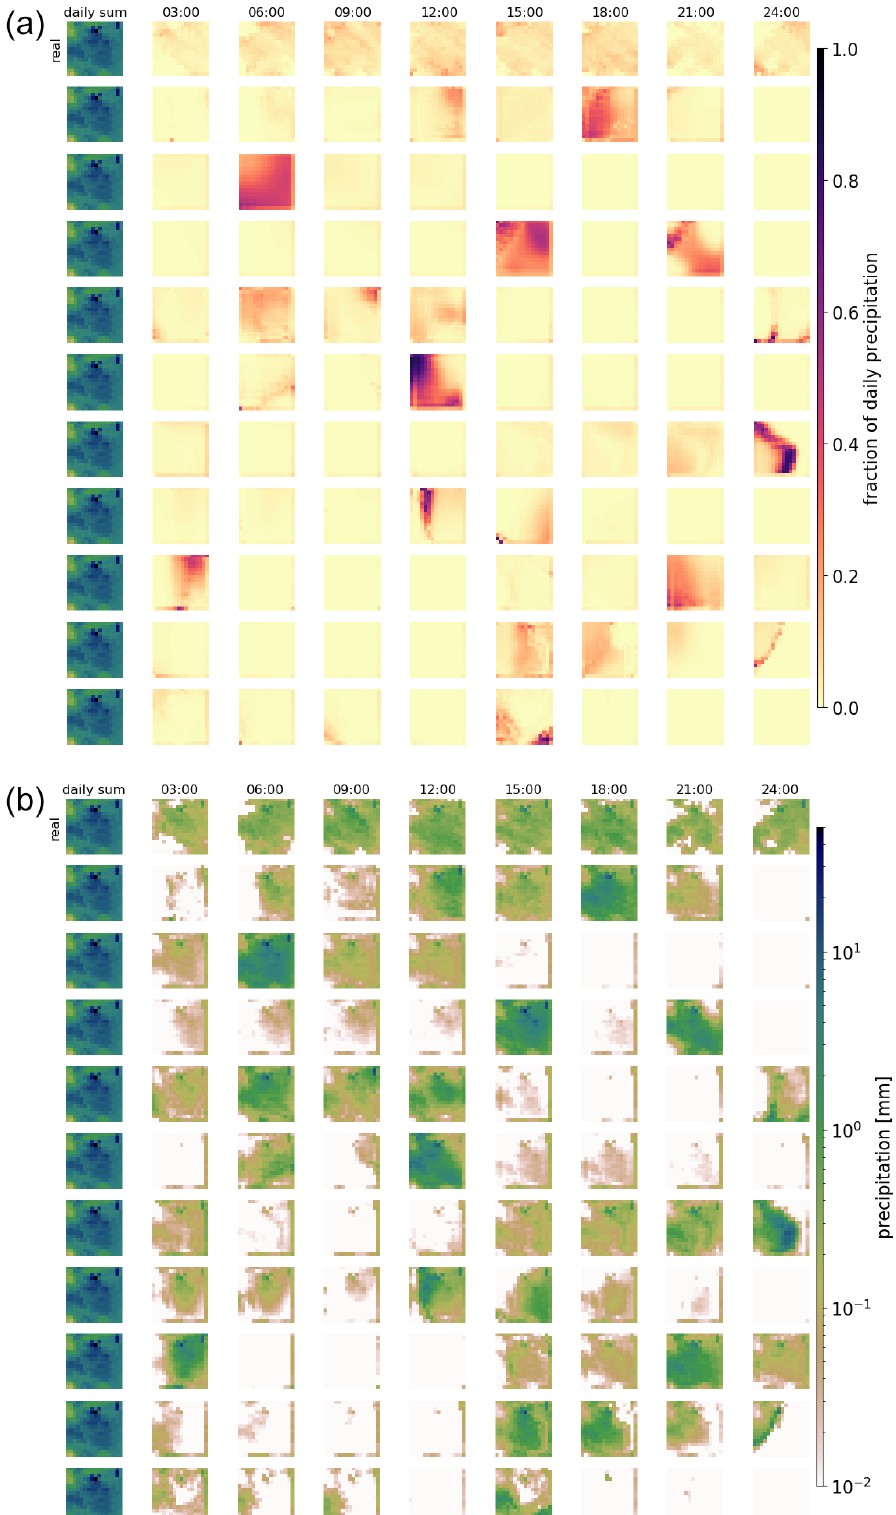
Figure 3. Real and generated examples of the fraction of hourly precipitation patterns for one daily precipitation sum and the hourly precip- itation itself. Panel (a) shows the generated fractions, and (b) shows the corresponding hourly precipitation patterns. The leftmost column of each panel displays the daily sum precipitation field used as the condition. The remaining columns show the values for every third hour. The first row presents the observed distribution over the day. The remaining rows show examples generated by the